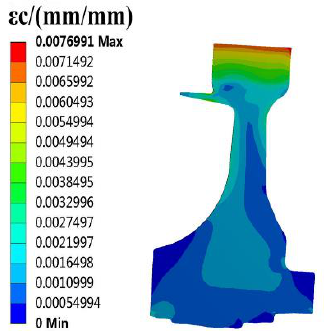
Figure 7. Distribution of blade creep strain.